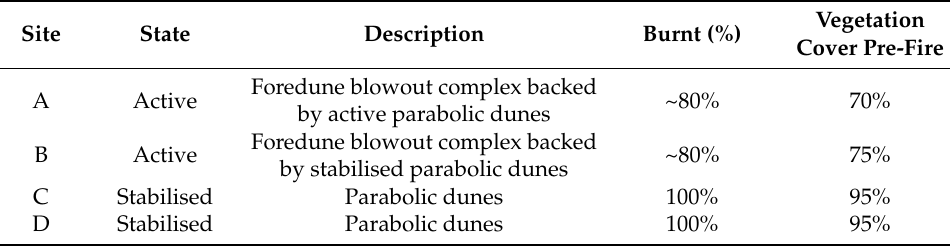
Table 3. Representative coastal dune sites used to assess fire severity with aerial and satellite imagery. Site State Description Burnt (%)